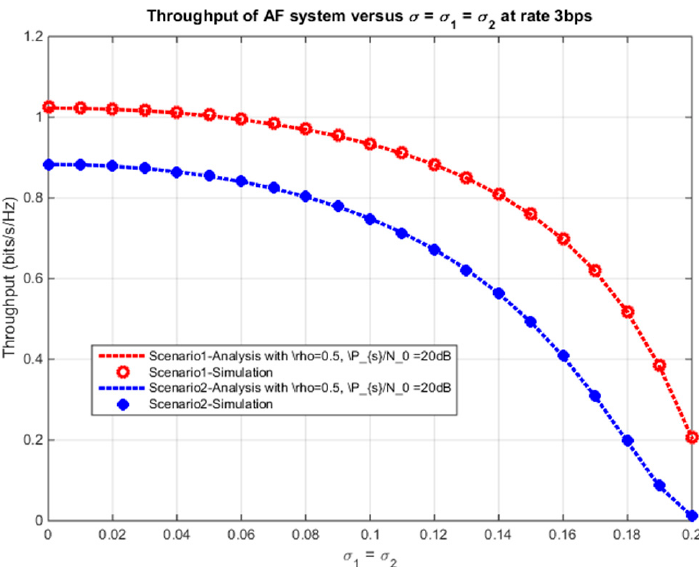
Figure 10. The throughput versus σ 1 = σ 2 .